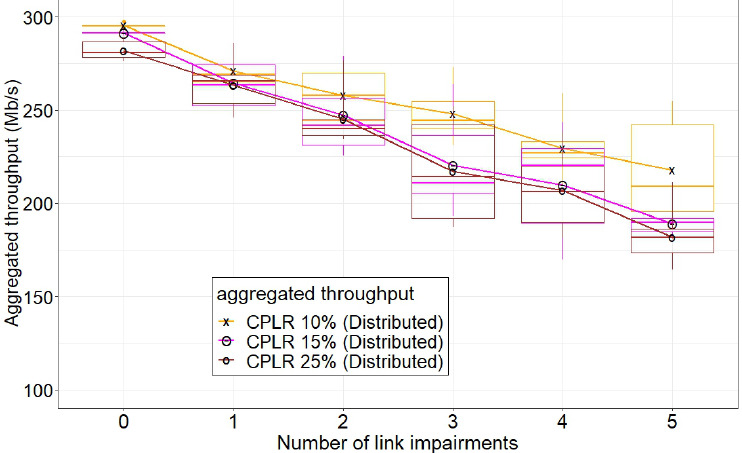
Figure 14. Aggregated throughput behavior of distributed network operation, during data plane link failures for various times under unreliable channel conditions in a 16-node grid network.